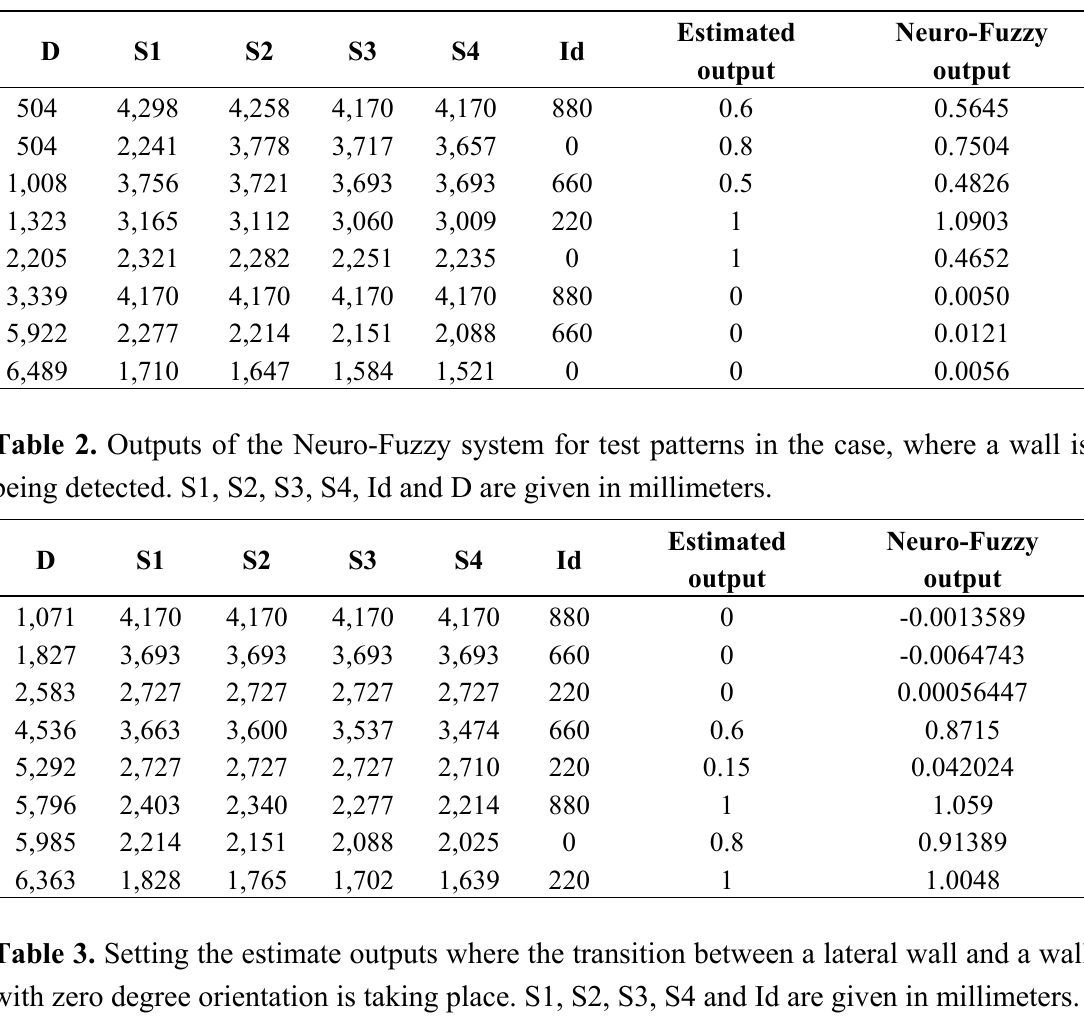
Table 1. Outputs of the Neuro-Fuzzy system for test patterns in the case, where a corner is being detected. S1, S2, S3, S4, Id and D are given in millimeters.